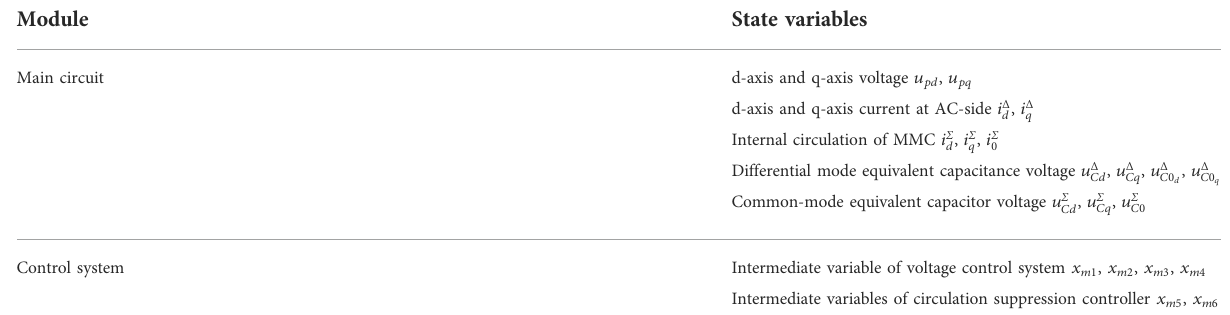
TABLE 2 Classi fi cation and meaning of state variables of the MMC